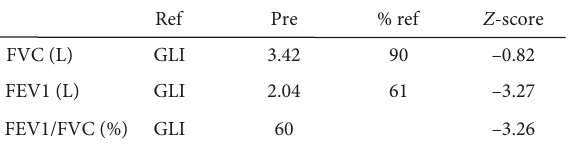
Figure 1: Lung function two weeks prior to the